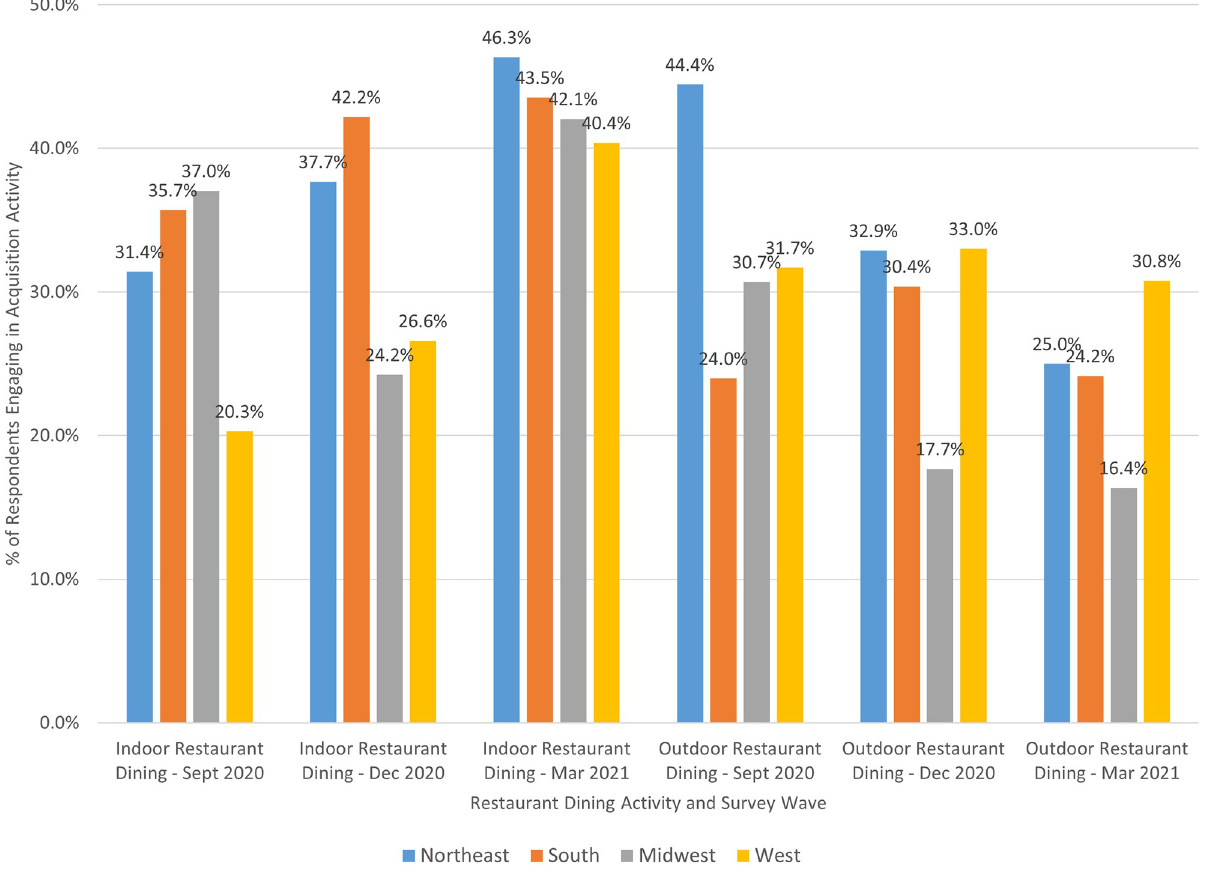
Fig 3. Restaurant dining behavior by survey wave and geographic